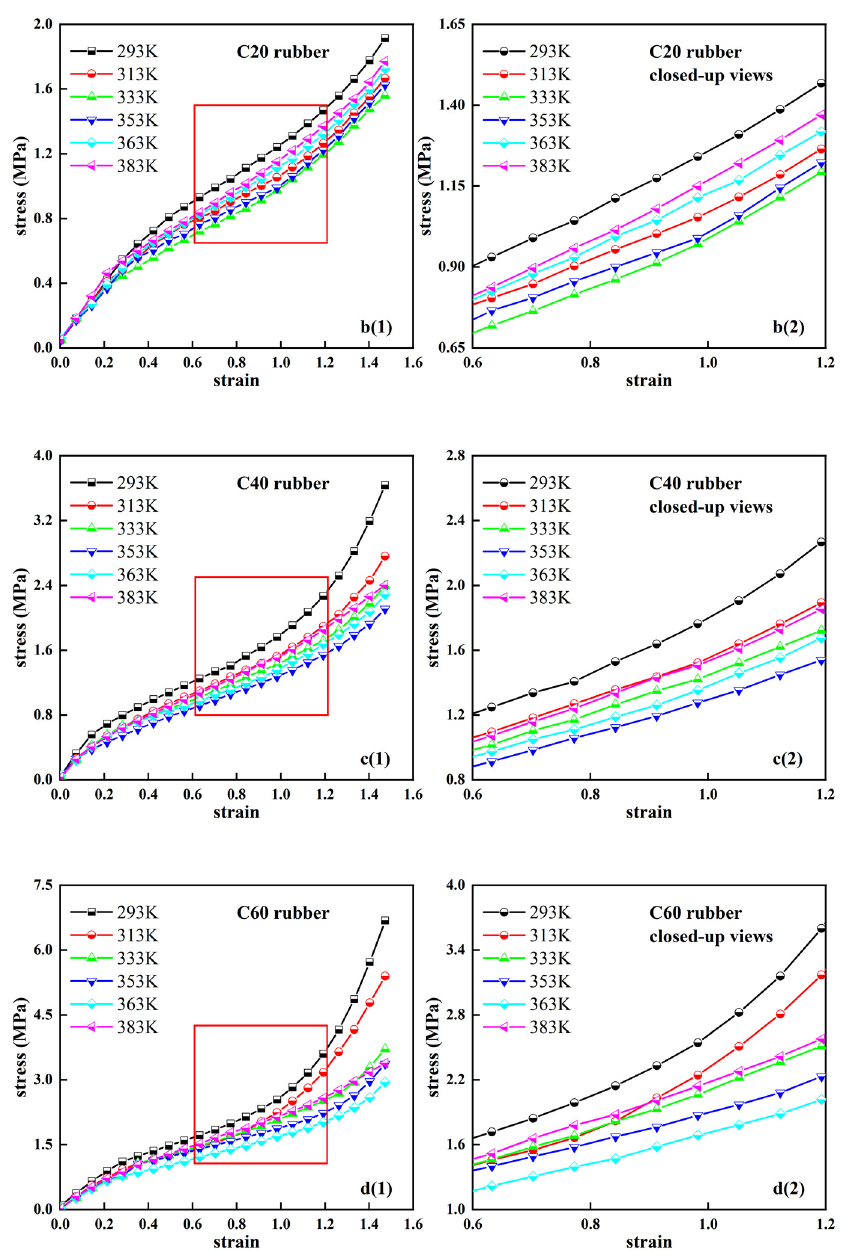
Figure 1. Stress–strain fitting curves of four types of rubber compounds at different temperatures based on the eight-chain model. ( a1 , b1 , c1 , d1 ): fitting curves and experimental data of four types of rubbers; ( a2 , b2 , c2 , d2 ): corresponding local closed-up views.